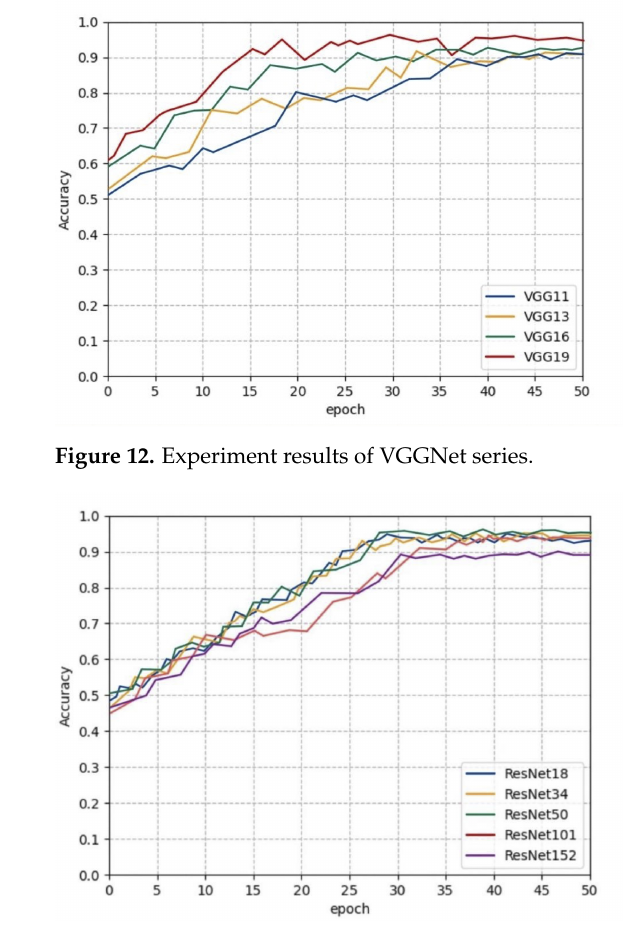
Figure 13. Experiment results of ResNet series.